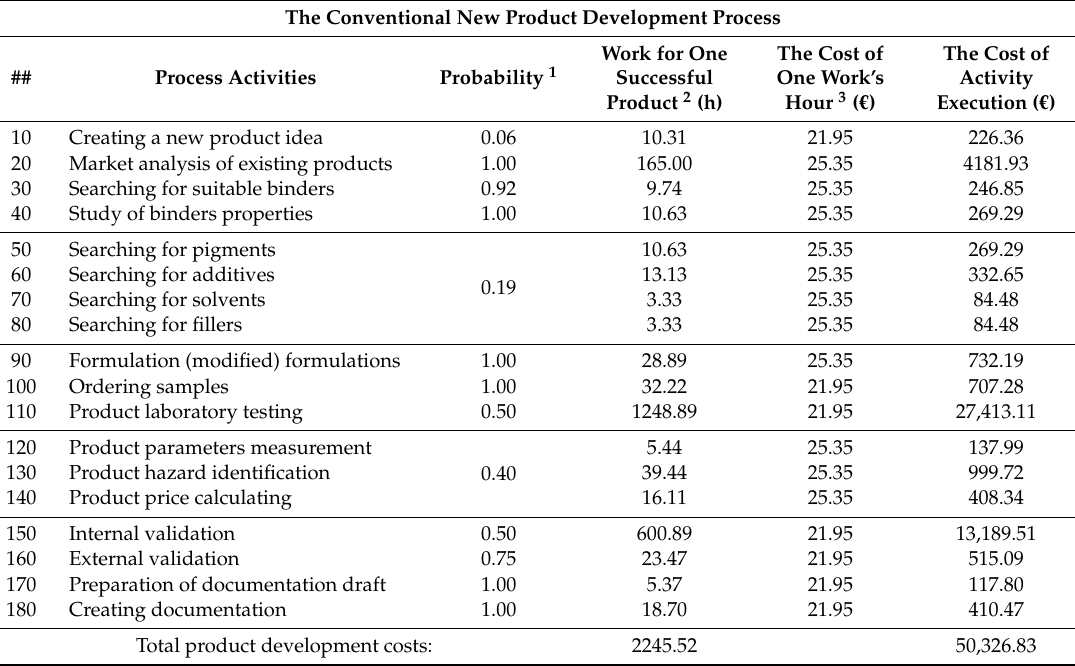
Table 1. Key activities of the conventional new product development